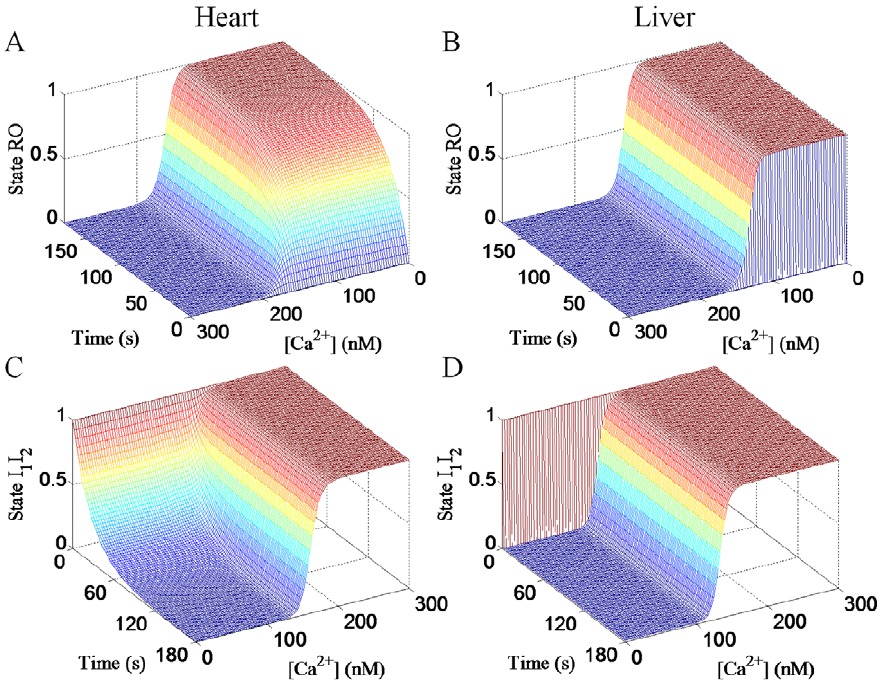
Figure 3. The major differences between the dynamics of the RaM model parameterized with the heart and liver parameters. The model was used to simulate the fraction of RaM in state RO and I 1 I 2 as a function of [Ca 2 + ] and time to highlight the quantitative differences between heart and liver RaM as suggested by the available experimental data. Heart RaM only recovers back to the resting state when Ca 2 + levels fall below 100–150 nM and sufficient time has passed (60–90 s). Liver RaM shows a very similar Ca 2 + -dependence; however, the time-dependence for recovery is much shorter (less than 1 s).